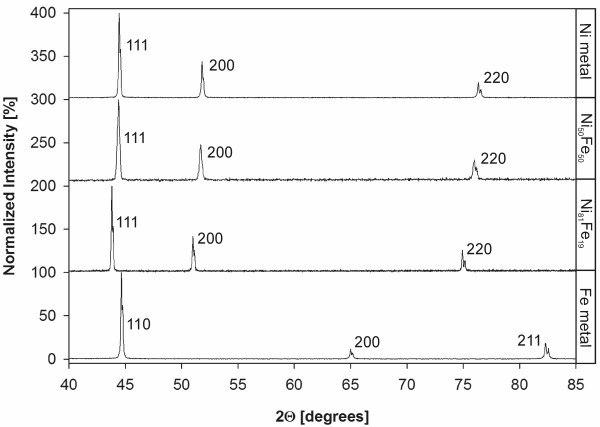
XRD patterns of metals/alloys used in this study. Note the similarity in patterns of Ni, Ni50Fe50 and Ni81Fe19 stemming from the same space group (Fm-3m). Fe0 possesses Im-3m space group.